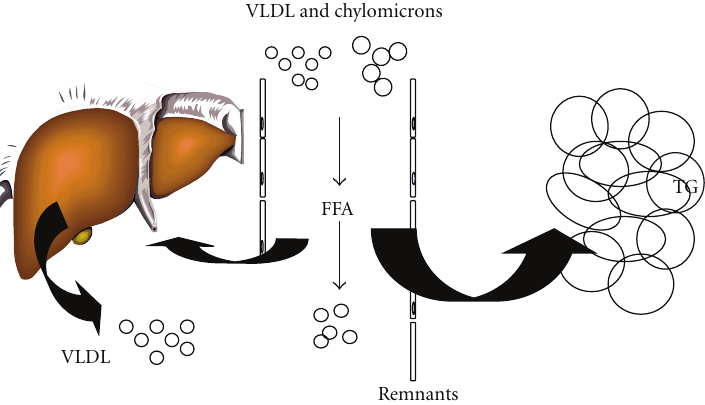
Figure 1: Postprandial lipid and FFA metabolism. In the postprandial phase, endogenous (VLDL) and exogenous (chylomicrons) TRL compete for clearance by LPL, which hydrolyzes TG into glycerol and FFA, leaving atherogenic remnant particles. The lipolytic rate, as well as the clearance of remnant particles by liver receptors, contributes to removal of TRL from the circulation. Adipose tissue plays a crucial role in regulating FFA concentrations by suppressing the release of FFA in the circulation and stimulating the uptake of FFA liberated from TRL by LPL. This pathway is known as the pathway of adipocyte FFA trapping.